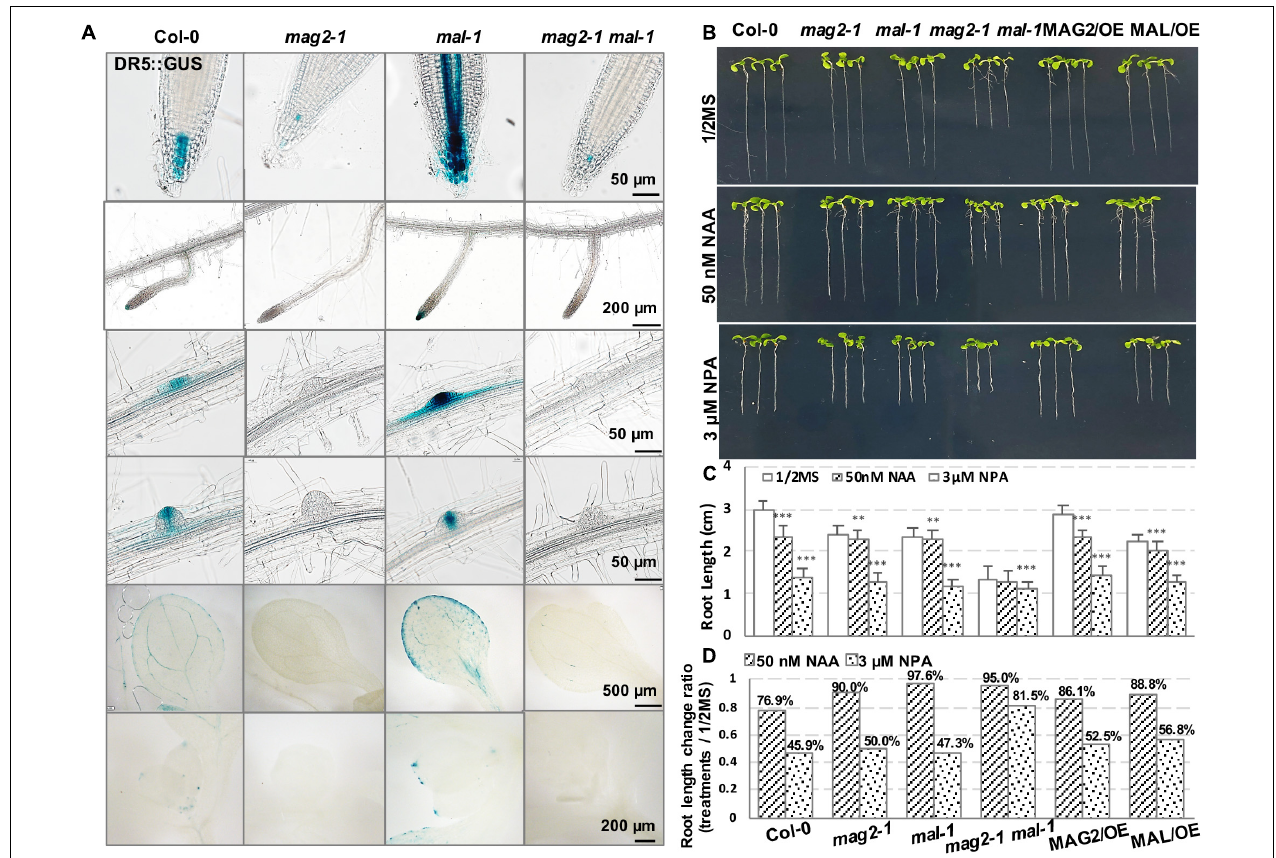
FIGURE 6 | MAG2 and MAL regulate auxin distribution. (A) Tissue expression pattern of DR5:GUS. Bars are as shown. (B) Seven-day-old seedlings grown in the 1/2 MS medium with 50 nm NAA or 3 µ M NPA. (C) Statistics of root length in panel (B) . Values are means ± SD; n = 30, three repeats per sample. (D) Statistics of root length ratio before and after treatment in panel (C) . ∗∗ p < 0.01, and ∗∗∗ P < 0.001. Significance was evaluated by Student’s t -test using IBM SPSS Statistics